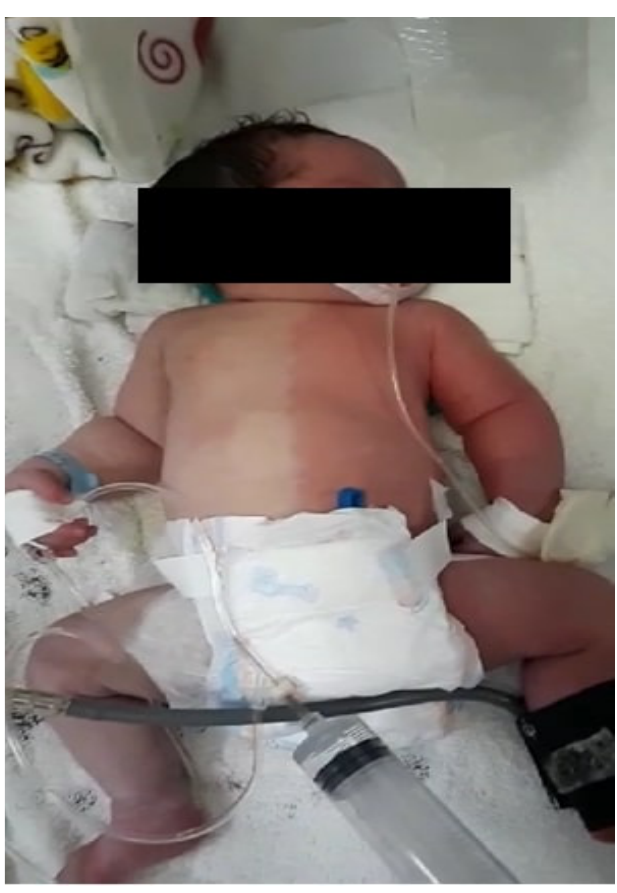
Figure . Harlequin Phenomenon in a Newborn. Regional Skin Discoloration with Sharp Edges, Affecting the Face and Right and Left Hemibody of the Newborn.